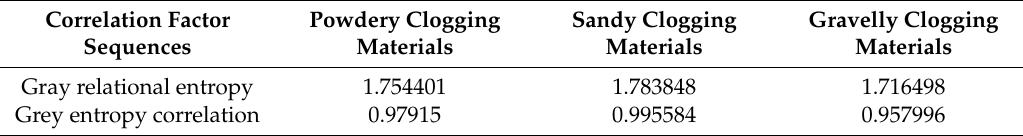
Table 13. Calculation results of correlation factor sequences by gray relation entropy